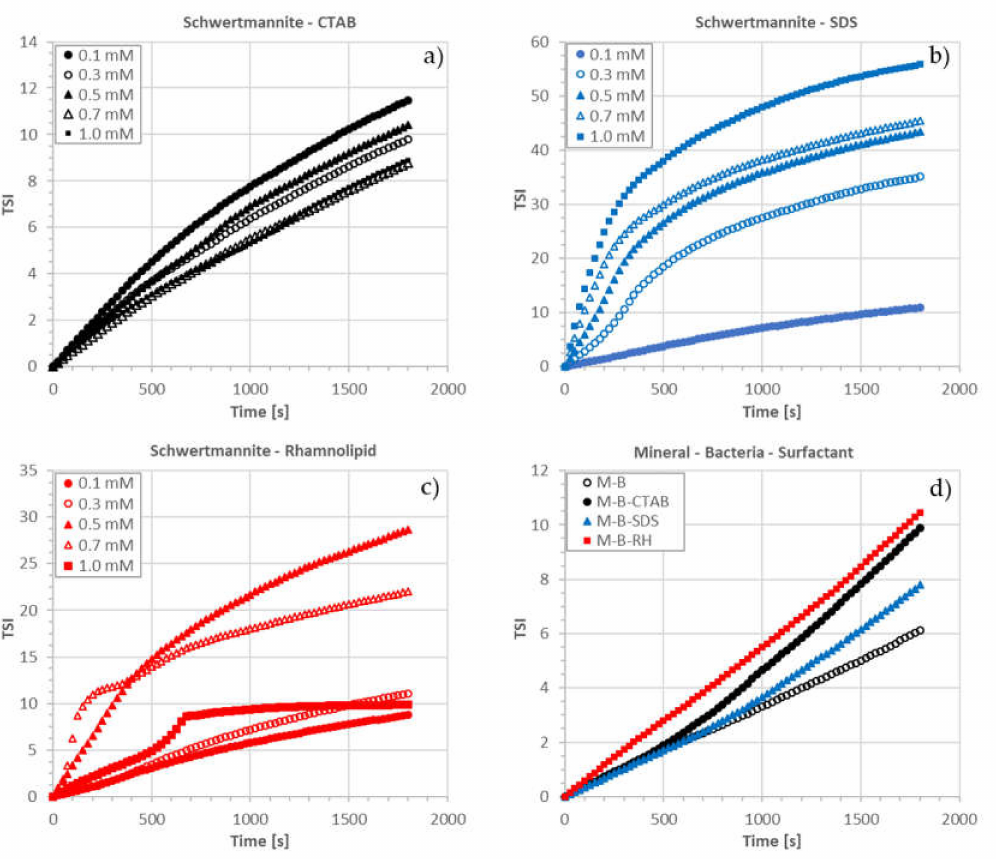
Figure 5. Results of stability measurements for various systems: schwertmannite (M) with ( a )